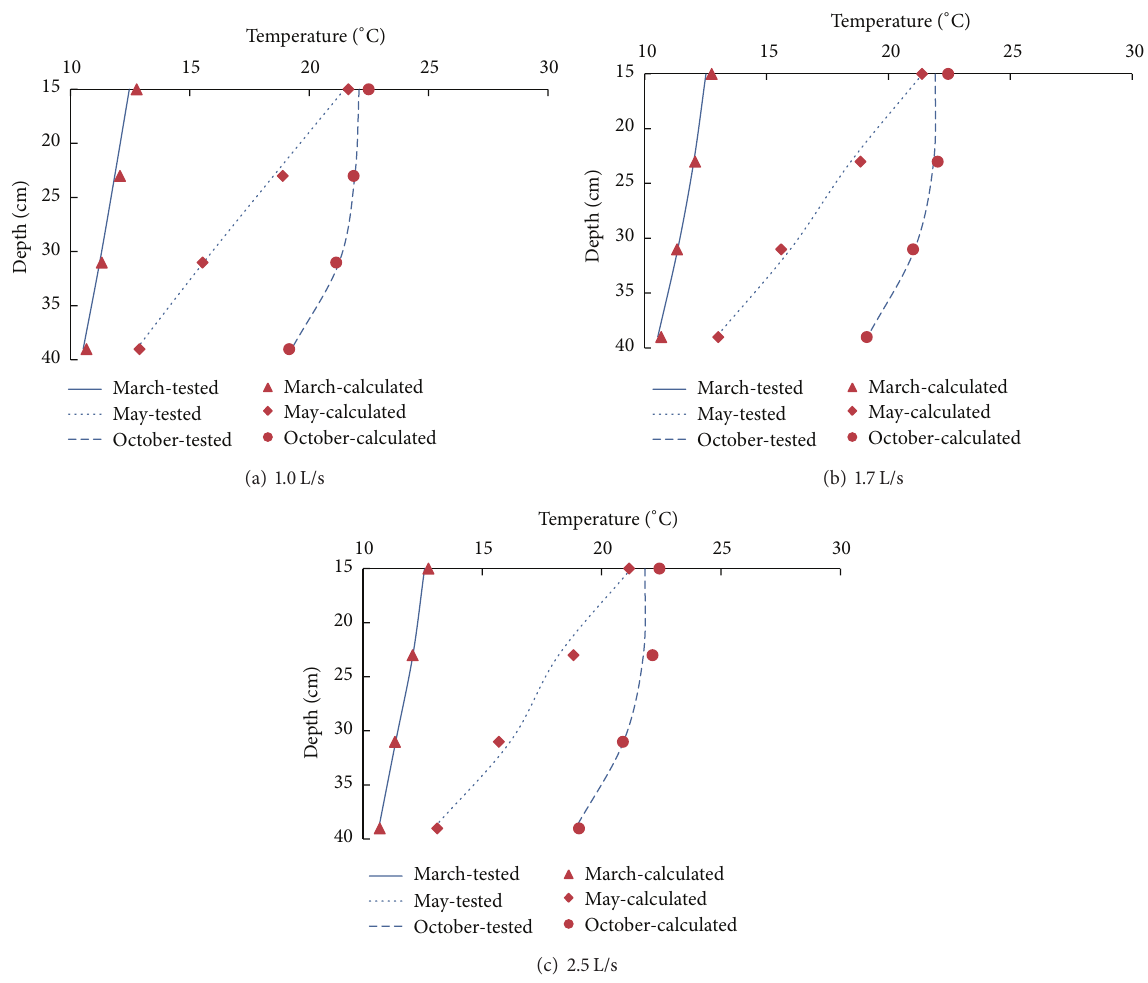
Figure 8: Comparison between the test value and the calculated